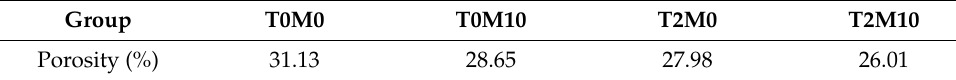
Figure 9. Pore size distribution of the MK blended pastes with BTE: ( a ) log differential intrusion; ( b ) cumulative intrusion. Table 3. Porosity of produced MK blended pastes with BTE.